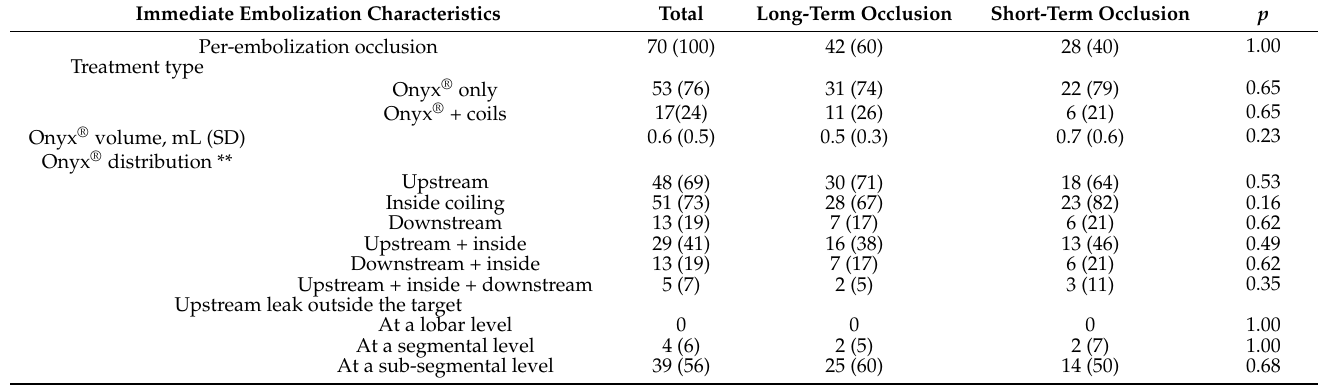
Table 3. Onyx ® embolization data and immediate complications in all PAVMs and in the two groups, short- and long-term